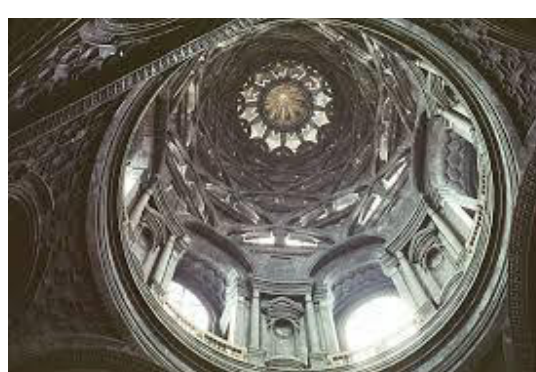
Fig. 15 The Cathedral of Vigevano, 17 th century